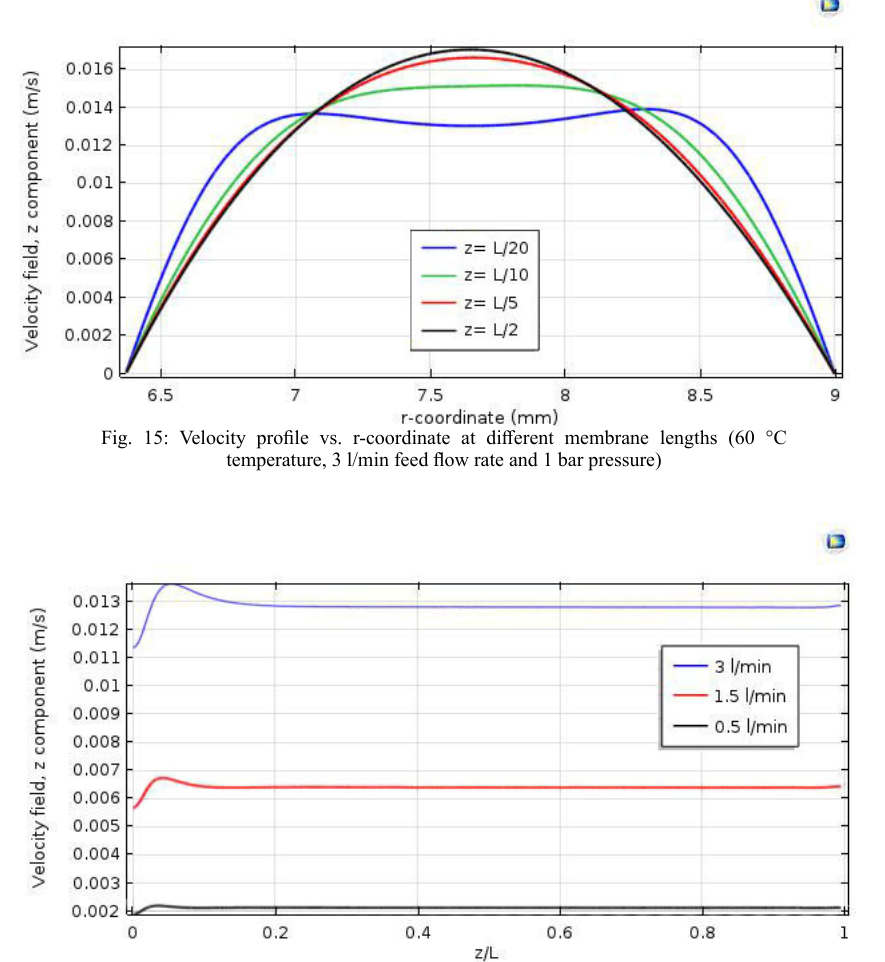
Fig. 16: Velocity profile vs. dimensionless membrane length at different feed flow rates (60 °C temperature and 1 bar pressure)